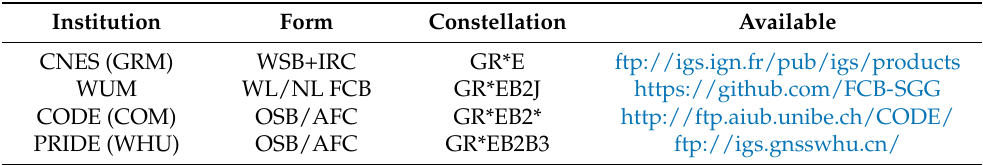
Table 1. An overview of the PPP AR products of the end of May 2021 (The websites were accessed on 16 August